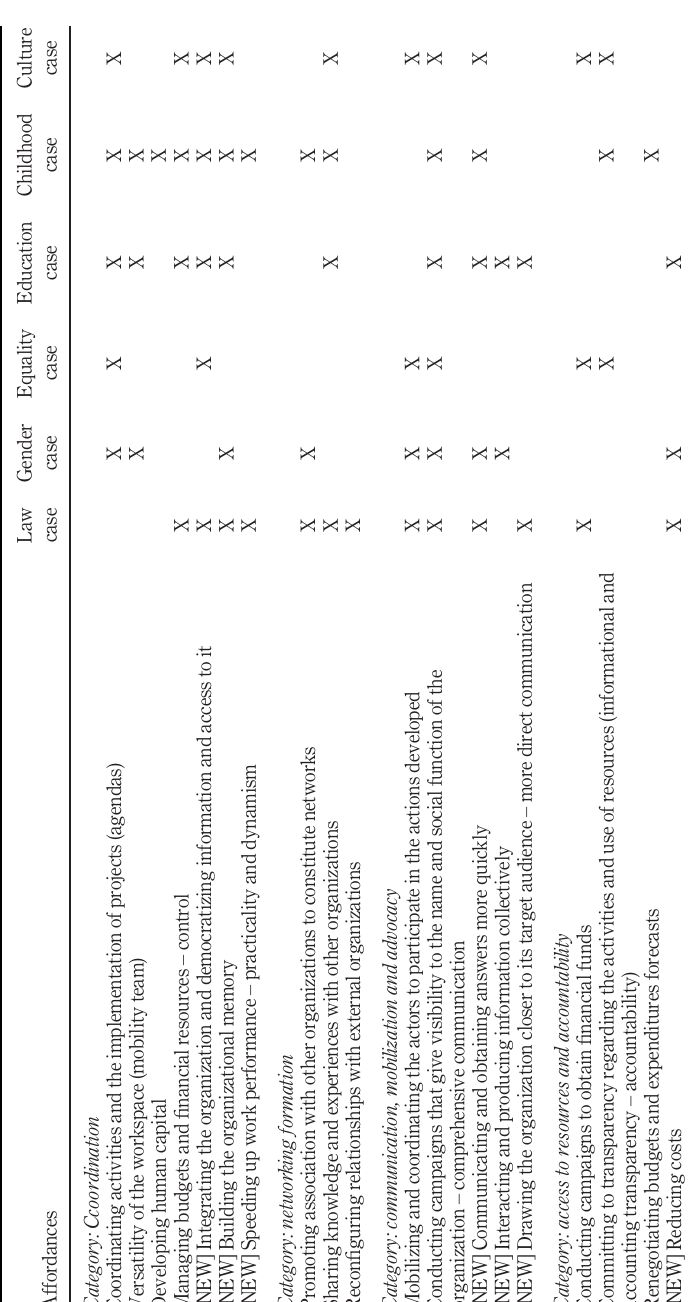
Table V. Affordances of technology in the investigated